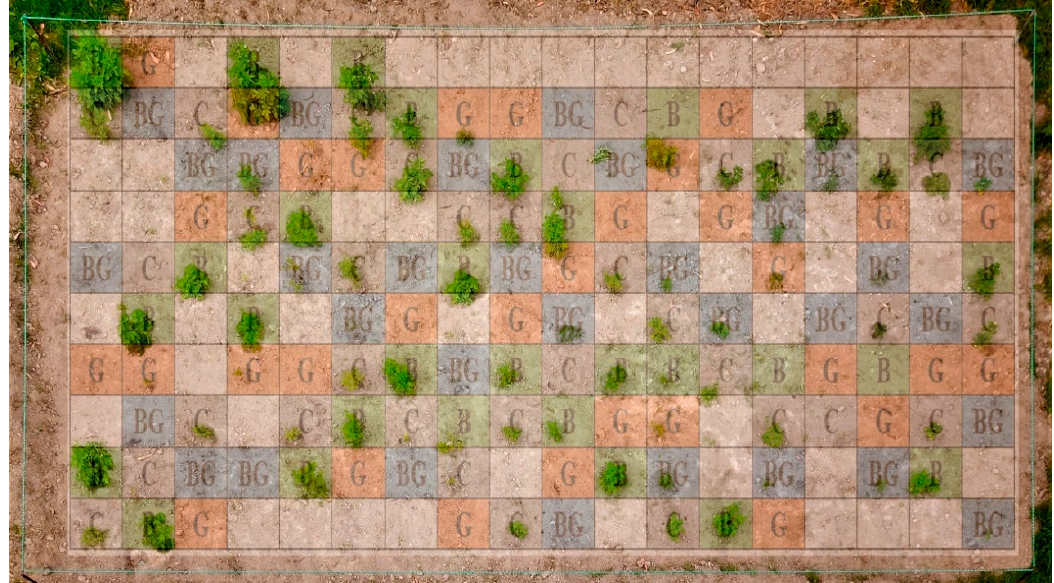
Figure 9. Aerial photograph of the crop distribution at day 60.